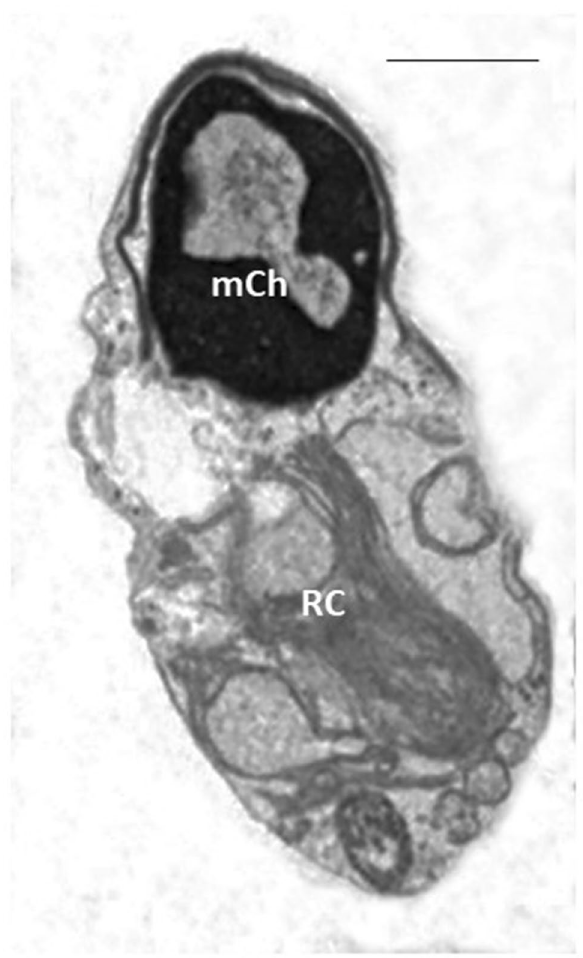
Figure 3. TEM micrograph of a longitudinal section of an apoptotic sperm showing altered nucleus with marginated chromatin (mCh) and the presence of a wide hole, a typical morphological characteristic of apoptosis. The acrosome does not completely fit with nuclear shape, a cytoplasmic residue (CR) and a section of an altered axonemal pattern are visible. Bar: 2